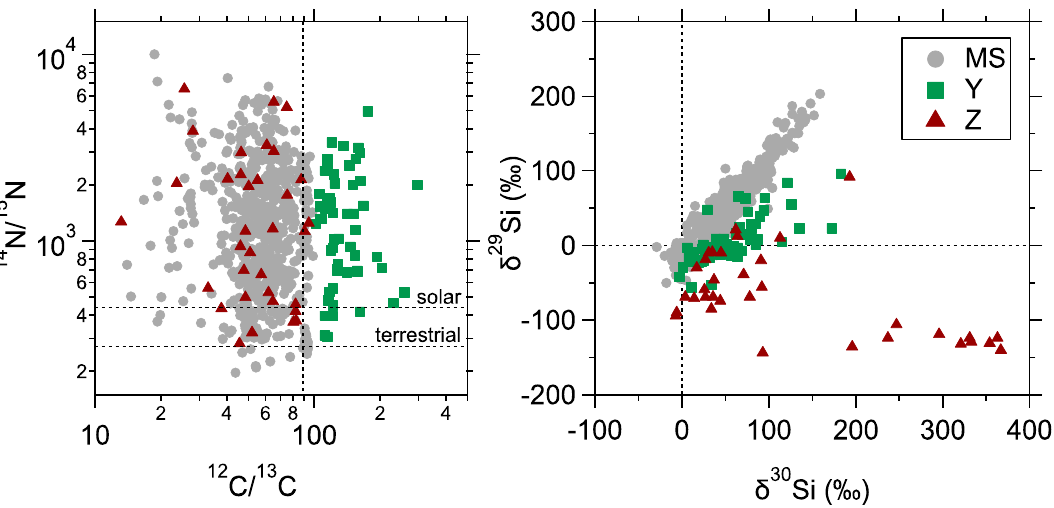
Figure 2. Nitrogen, C, and Si isotopic ratios of presolar SiC grains from low-mass C-rich AGB stars, including types MS, Y, and Z grains [52]. The Si isotope ratios are expressed in δ notation, which is calculated using the equation δ i Si = [( i Si/ 28 Si) grain /( i Si/ 28 Si) solar − 1] × 1000‰. Unless noted otherwise, the dashed lines represent the terrestrial composition.